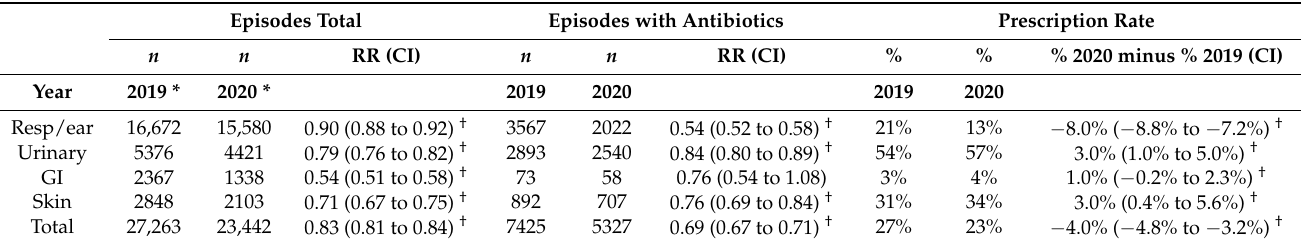
Table 1. Number of disease episodes and episodes with antibiotic prescription for respiratory/ear, urinary tract, gastroin- testinal and skin infections in 2019 and 2020 (March through May).